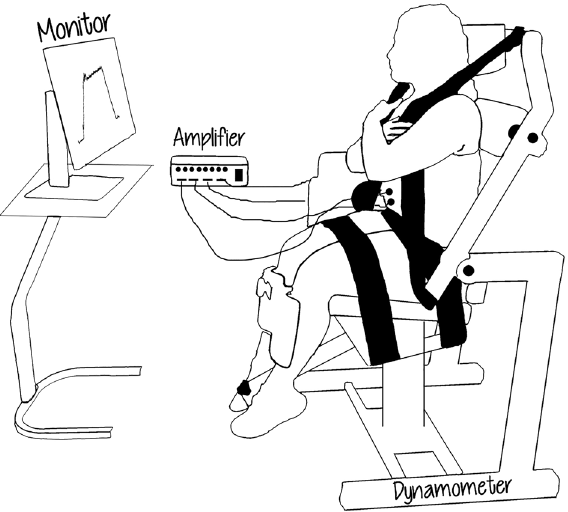
Figure 2. Representation of the testing procedure. A participant is seated on the Biodex chair with the electrodes attached to her and connected to the amplifier, and she performs isometric back extension at one of the two torque levels, while visual feedback of the torque output is provided to her via a